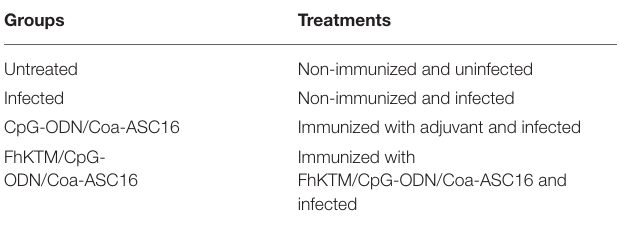
TABLE 1 | Processing mice in each